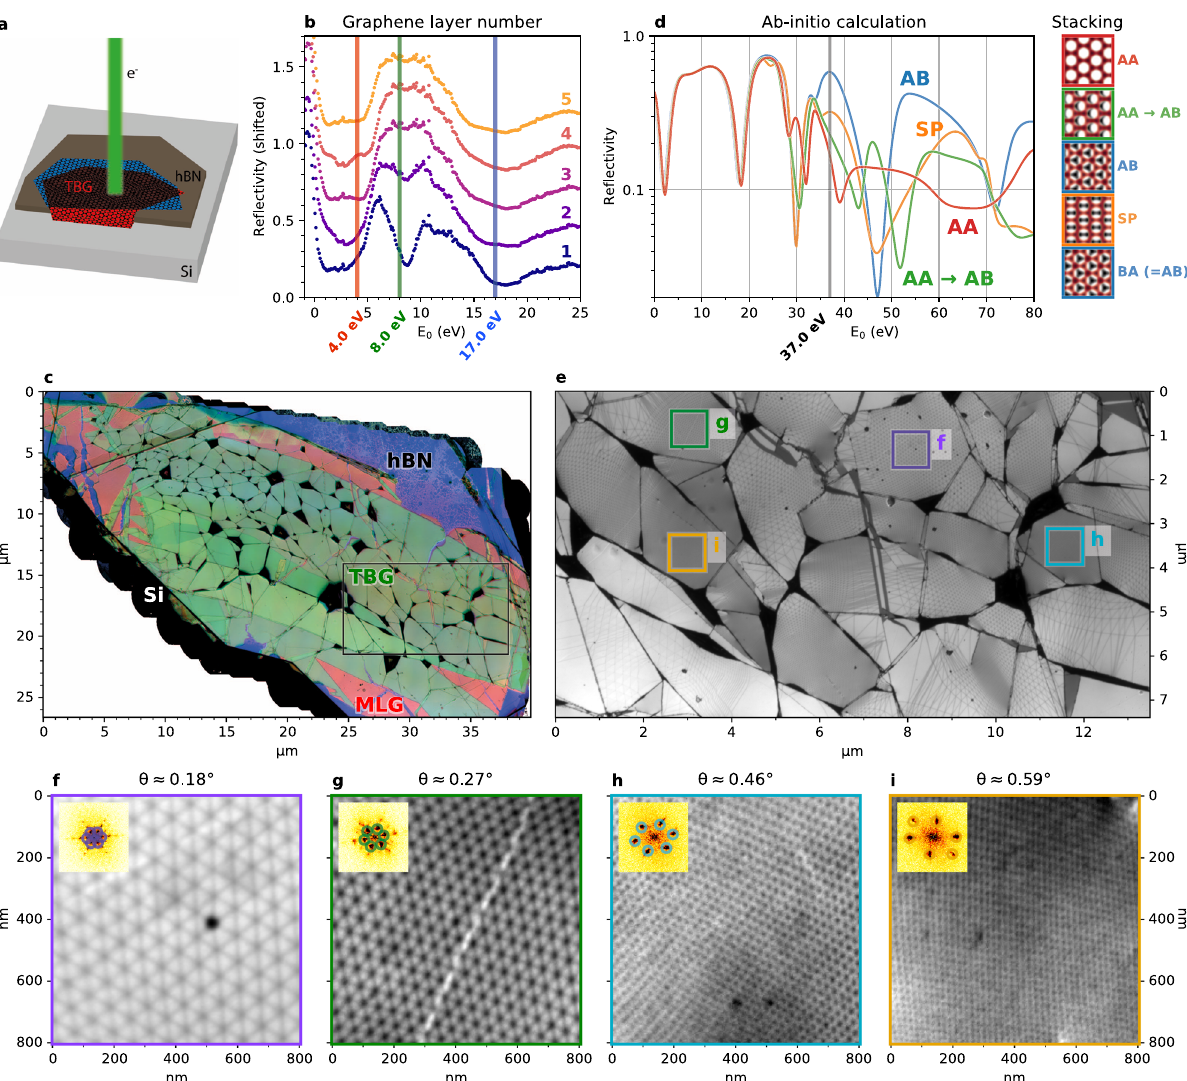
Fig. 1 Device-scale imaging of TBG. a Schematic of the sample, with two twisted graphene fl akes (TBG) on top of a hexagonal boron nitride (hBN) fl ake on a silicon (Si) substrate. b Local spectra that were used to determine the graphene layer count. Vertical lines indicate the imaging energies used for panel ( c ), the number of graphene layers for each spectrum is indicated on the right. c Stitched composite bright fi eld overview of a sample using 4, 8, and 17 eV as imaging energies in red, green, and blue respectively (see main text for color interpretation). Visible defects include folds in black, tears, where the monolayer (red/pink, indicated as MLG) or even bare hBN (blue, purple) shines through, bubbles (bright), and some polymer residue in the lower and upper right (dark speckles). The black rectangle indicates the area shown in panel ( e ). d Ab initio calculations of LEEM spectra of different relative stackings of bilayer graphene, 37 eV indicated. e Stitched bright fi eld overview of the same sample imaged at E 0 = 37 eV, for optimal stacking contrast, revealing the moiré patterns. f – i Crops of different twist angle areas from ( e ). Insets show Fourier transforms and the detected moiré peaks, with the average twist angle θ extracted from those indicated. All data shown in the main text have been collected from the sample represented in panel ( c